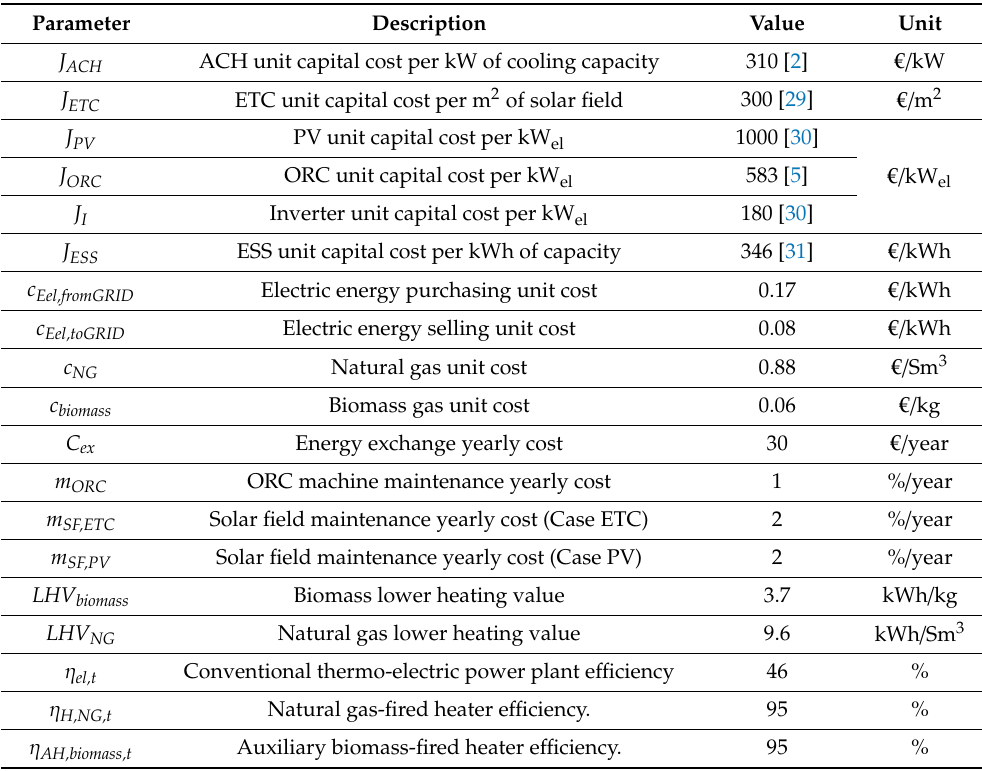
Table 5. Thermoeconomic